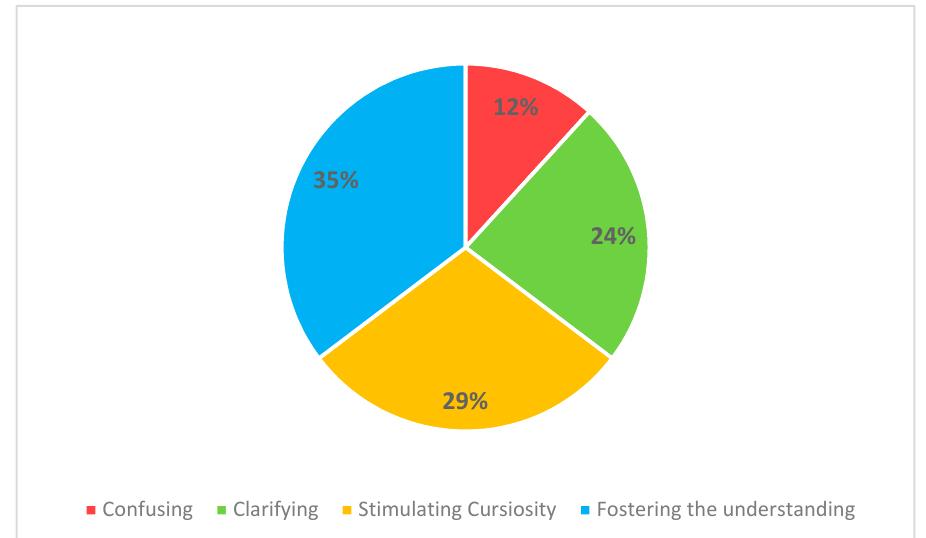
Figure 8. Assessment for the representation of population density using half-sphere, with color and size varying through time.